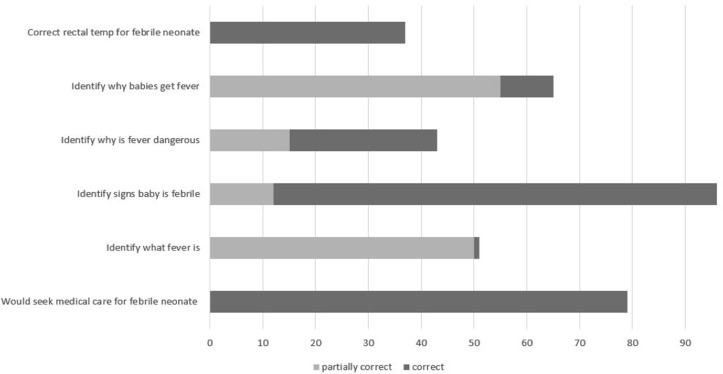
Response pattern of parents to questions about fever (% correct or partially correct).